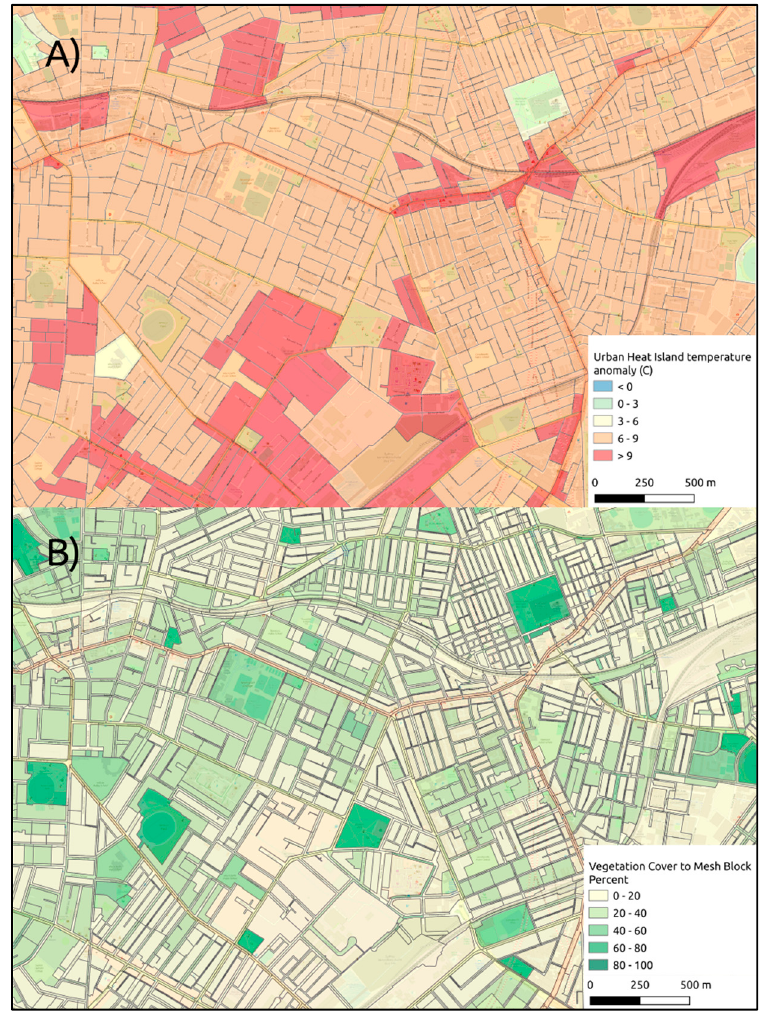
Figure 2. Urban heat island temperature anomaly ( A ) and % vegetation cover ( B ).